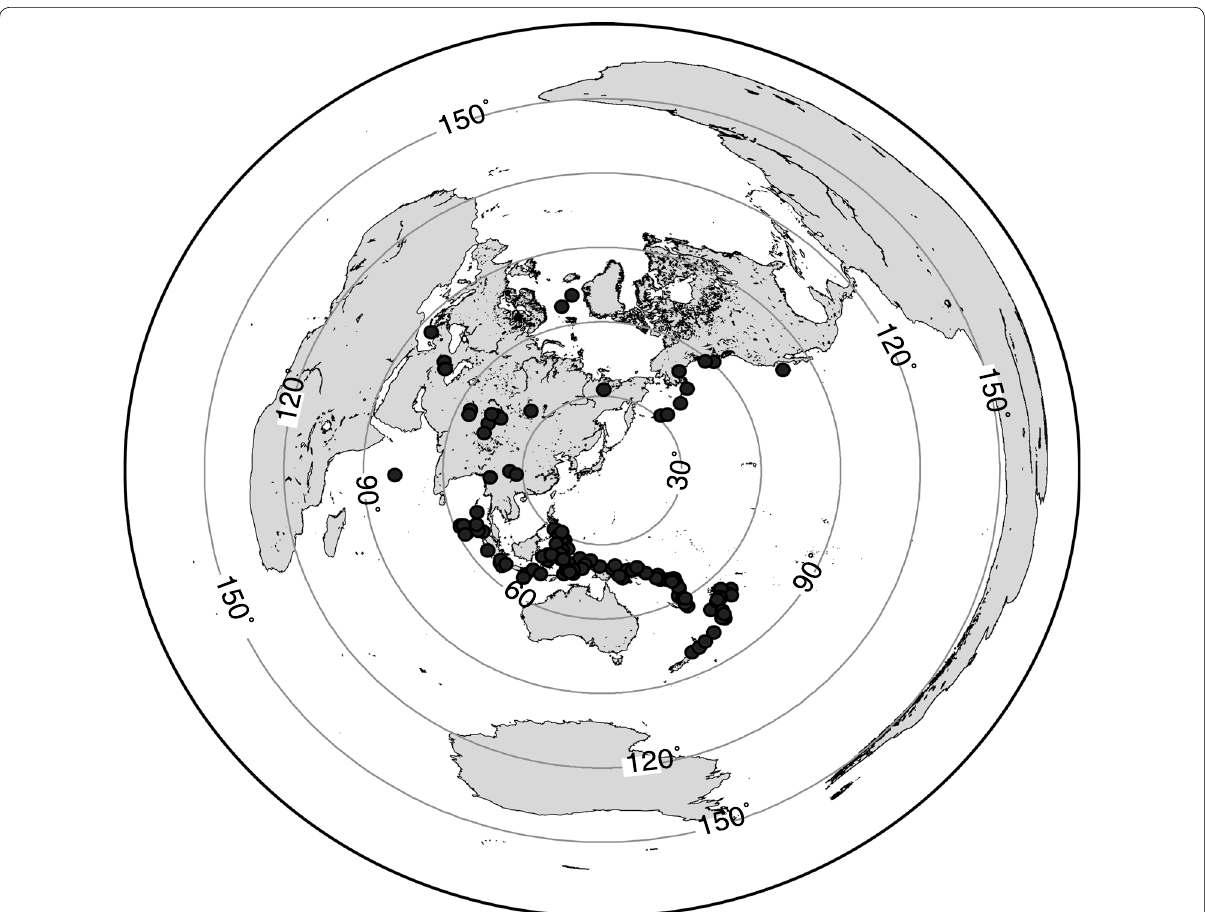
Fig. 3 Locations of the earthquakes used in the RF analysis. The center of the map is the off-Boso area. Dark gray circles indicate earthquake epicenters from the USGS